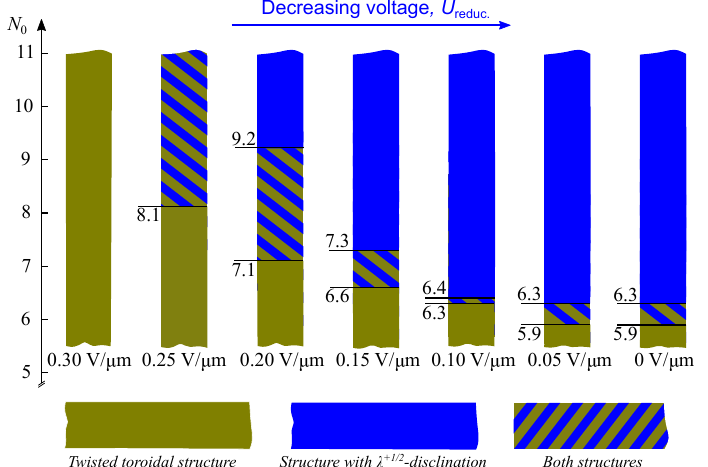
Figure 4. N 0 values at which a layer-like structure ( blue boxes ) and a twisted toroidal configuration ( olive boxes ) are observed, depending on an electric field E reduc . . The olive-blue boxes indicate the N 0 values at which both structures are observed in CLC droplets.